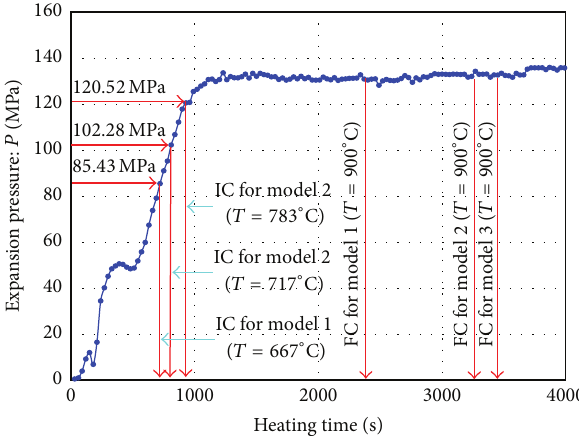
Figure 8: Internal pressure of the perforated cylinder